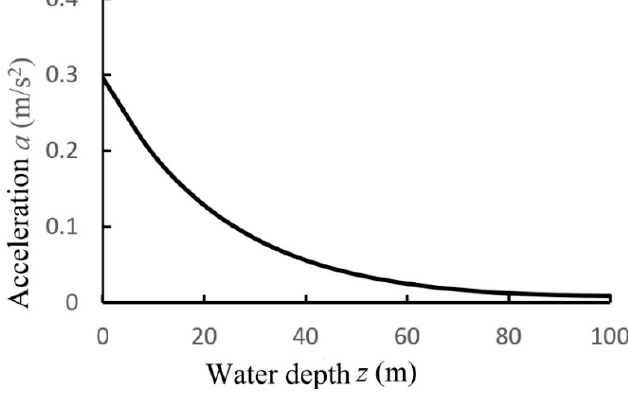
Figure 3. Maximum horizontal acceleration of water quality points at different water depths.